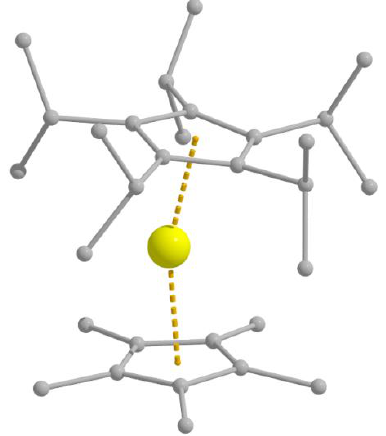
Figure 2. The molecular structure of the cation [(Cp i Pr5 )Dy III (Cp*)] + that is present in the Single-Ion Magnets (SIM) 4 , which holds the world record for the magnetic blocking temperature ( T B = 80 K); one description of this parameter refers to the maximum temperature at which it is possible to observe hysteresis in the field dependence of the magnetization, subject to the field sweep rate. The Dy III center is shown in yellow color. Modified from reference [36].